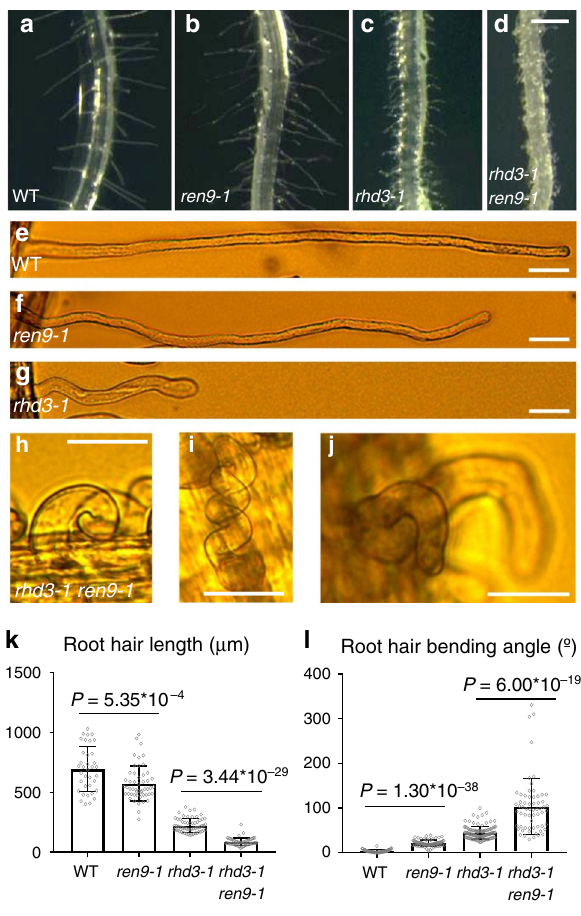
Fig. 1 Isolation of ren9 as an rhd3 enhancer. a – d Overview of root-hair phenotypes. Root segments of 5-day-old seedlings are shown. Scale bars = 0.5 mm. e – j Enlargements of representative root hairs. a , e wild-type; b , f ren9-1 ; c , g rhd3-1 , d , h – j rhd3-1 ren9-1 . Note that root hairs of rhd3-1 and ren9-1 were both wavy, but root hairs of rhd3-1 rend9-1 were curly or helical. Scale bars indicate 50 µ m. k – l Quanti fi cation of the length ( k ) and bending angle ( l ) of root hairs. Note that the root-hair length of ren9-1 was about 80% of wild-type, while the root-hair length of rhd3-1 ren9-1 was <40% of rhd3-1 ( k ). The bending of ren9-1 related to wild-type was ~18°, while the bending of rhd3-1 ren9-1 related to rhd3-1 was about 60° ( l ). Columns = mean values, error bars = standard errors. Gray circles represent actual data. P values indicated for signi fi cances between samples are calculated by Student ’ s t test (two-sided). In the order of wild-type, ren9-1 , rhd3-1 , and rhd3-1 ren9-1 , n (individual root hairs) = 36, 51, 60, 52 for root-hair length, n (individual root hairs) = 61, 75, 118, and 62 for root-hair bending angle,